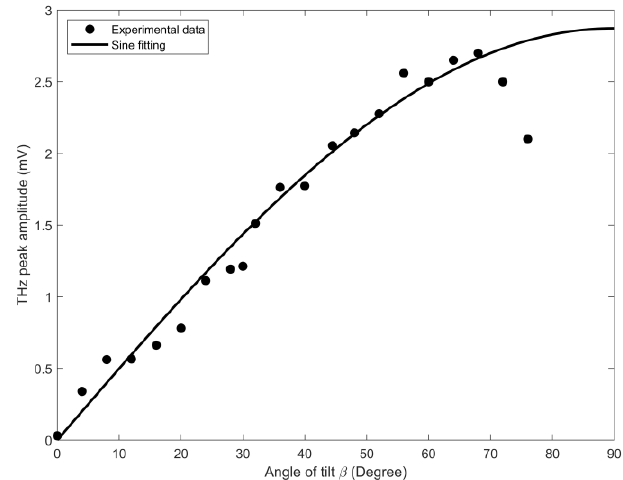
Figure 4. THz transient amplitude dependence on the tilt angle 𝛽 for a SI GaAs sample (dots). The fit (solid line) corresponds to the sine function in accordance with Equation (1). The drop in THz amplitude at ~70 ° (Brewster’s angle) is due to the total reflection of the THz wave in GaAs. Results for other samples are not shown, but they exhibit the same behavior.